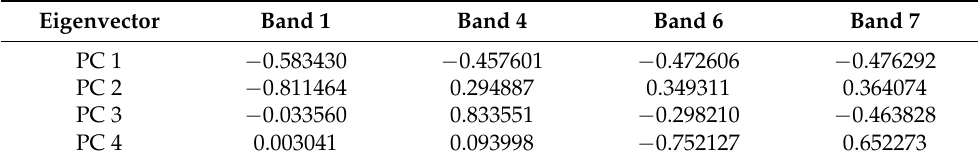
Table 6. Eigenvector matrix of selected bands for mapping phyllic zone derived from SPCA. Eigenvector